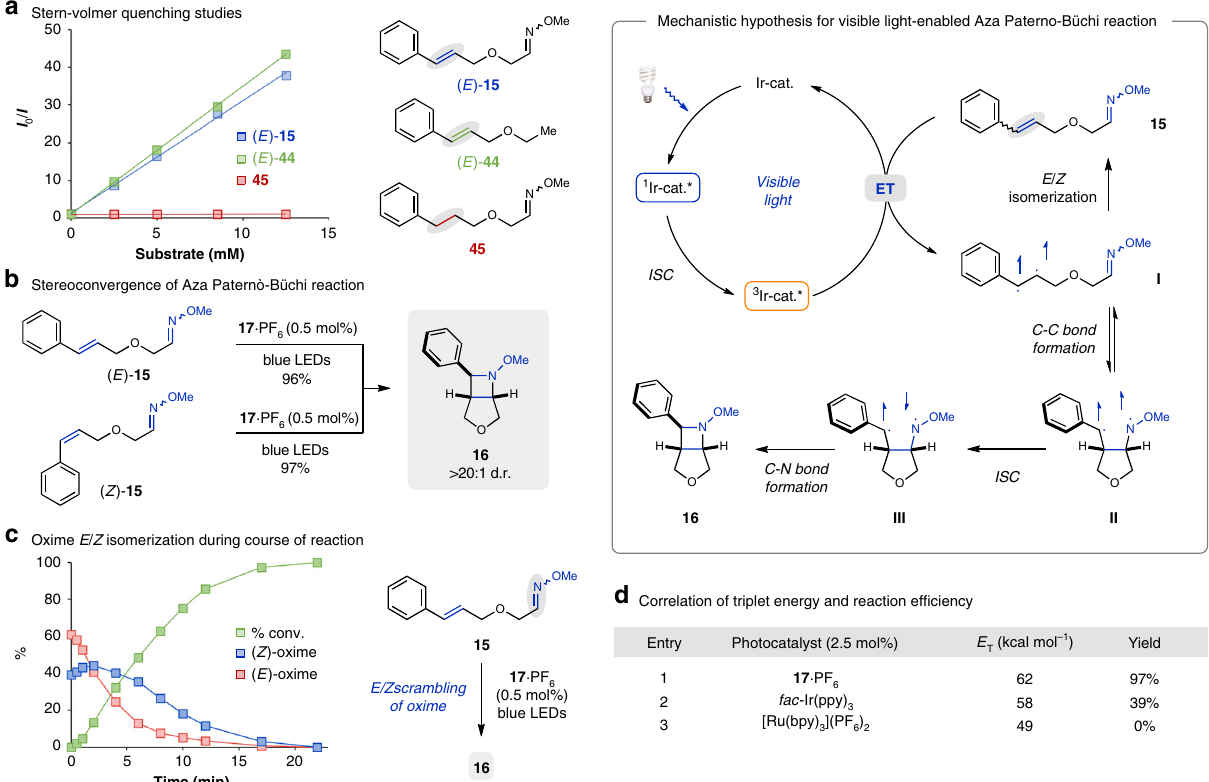
Fig. 5 Mechanistic investigations of the title reaction. a Stern – Volmer quenching studies. b Stereoconvergence of the aza Paternò – Büchi reaction. c Oxime E / Z isomerization during the course of the reaction. d Correlation of triplet energy and reaction ef fi ciency (see Supplementary Methods for details). E triplet energy; ET = energy transfer; ISC = intersystem crossing